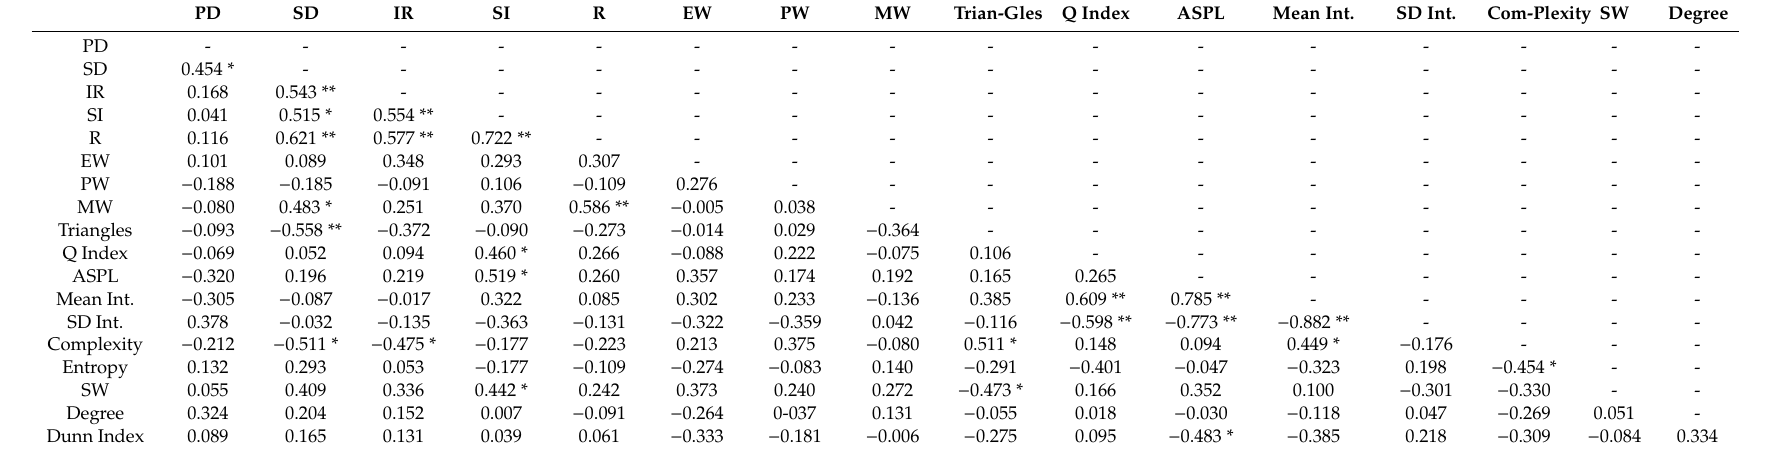
Table 4. Correlation matrix between QoL dimensions and graph theory